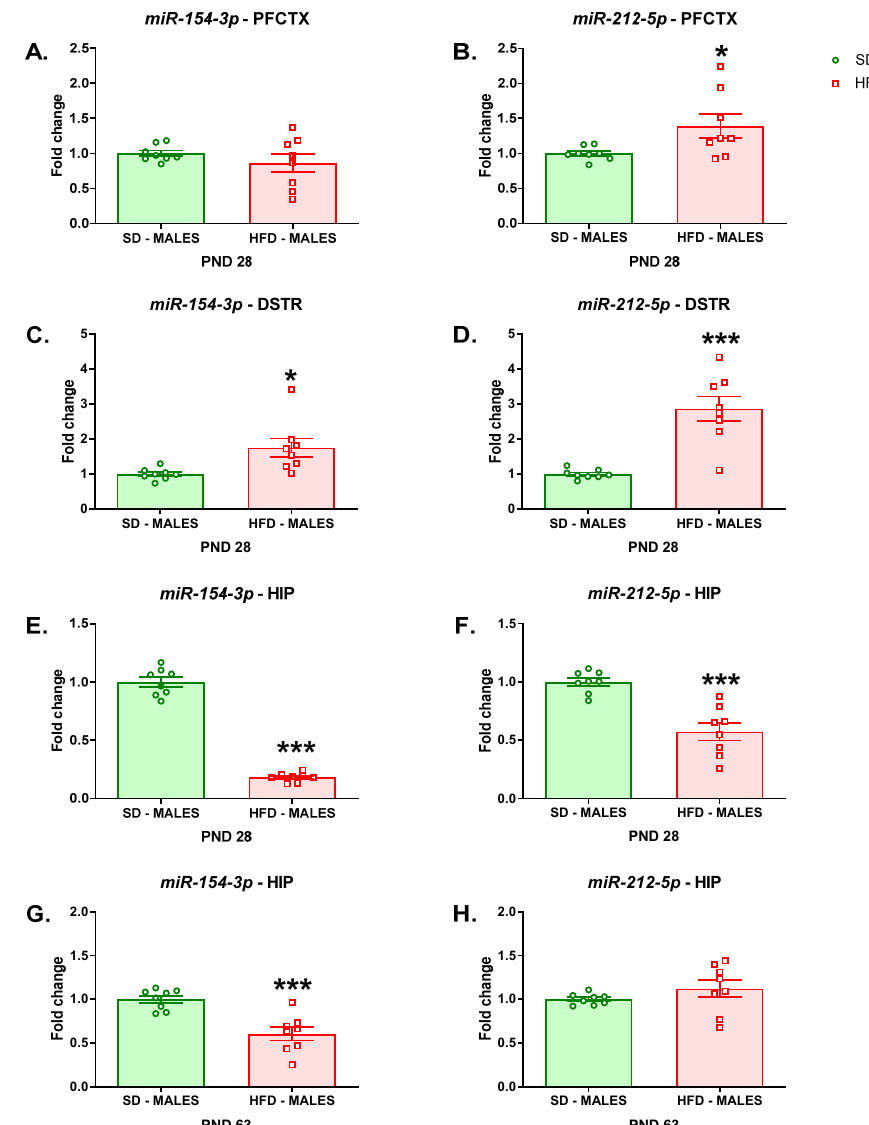
Figure 4. Effects of a maternal HFD during pregnancy and lactation on the levels of miR-154-3p and miR-212-5p in the ( A ), ( B ) PFCTX, ( C ), ( D ) DSTR, and ( E ), ( F ) HIP of adolescent offspring and in the ( G ), ( H ) HIP of young adult offspring. DSTR—dorsal striatum; HFD—high-fat diet; HIP—hippocampus; PFCTX—prefrontal cortex; PND—postnatal day; SD—standard diet. Data are presented as the mean ± SEM with individual value plots. N = 8 rats/group. * p < 0.05; *** p < 0.001 vs. SD.